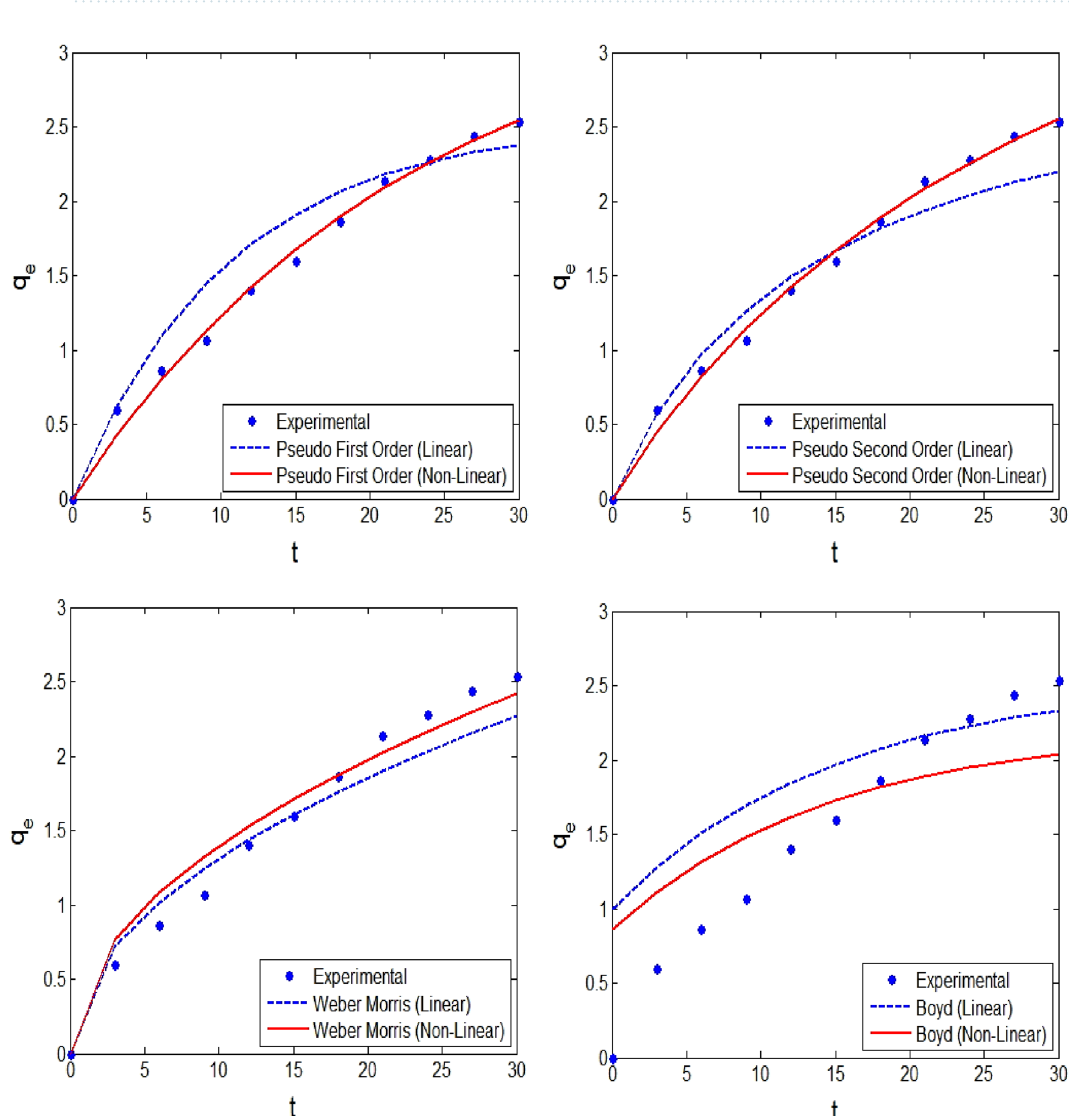
Figure 9. Kinetic plots for the adsorption of diazinon by pumice (initial diazinon concentration = 50 mg/L, pumice dosage = 1 g/L, and pH =